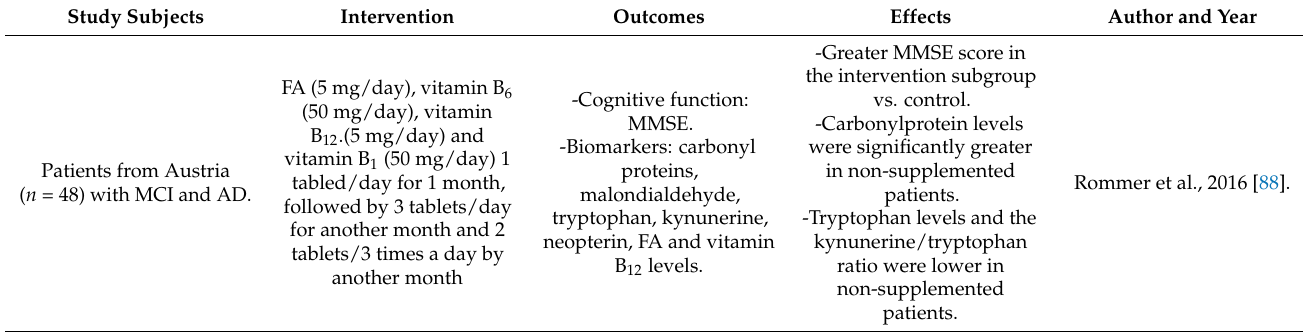
Table 4. Summary of the interventions based on folic acid combined with other nutrients. Study Subjects Intervention Outcomes Effects Author and Year